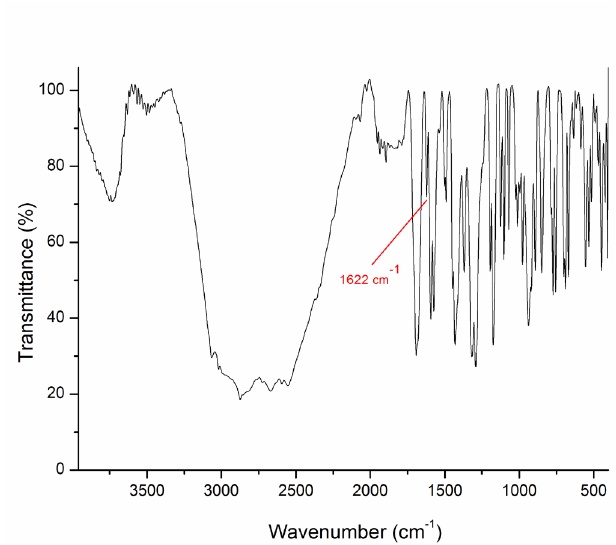
FIGURE 1 – FT-IR spectrum of 4-(benzylideneamino)benzoic Acid.